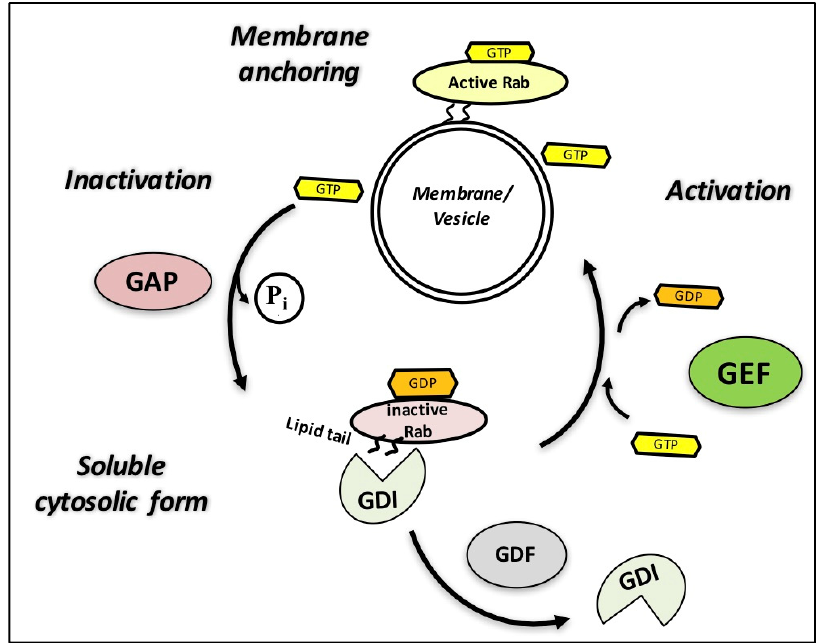
Figure 3. Activation/deactivation cycle of Rab guanosine triphosphate hydrolases (GTPases). In their active GTP-bound form, Rab GTPases are attached to the inner membrane and recruit various e ff